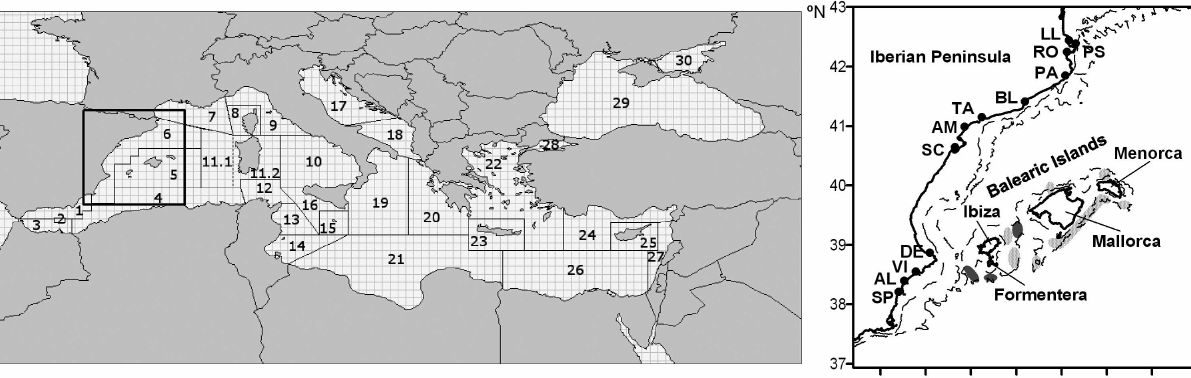
Fig . 1. – Map of the Mediterranean Sea showing the thirty geographical sub-areas (GSAs) established by the General Fisheries Commission for the Mediterranean (GFCM). The inlet details GSA05 (Balearic Islands) and GSA06 (Northern Spain) showing the names of several ports from GSA06 and the different islands of the Balearic Archipelago mentioned in the work; the isobaths are 100 and 800 m. Red shrimp and caridean shrimp fishing grounds of GSA05 exploited by trawlers from GSA06 are also shown in dark grey and grey respectively (adapted from García-Rodríguez and Esteban, 1999; and García-Rodríguez et al. 2000). LL: Llançà; PS: Port de la Selva; RO: Roses; PA: Palamós; BL: Blanes; TA: Tarragona; AM: Ametlla de Mar: SC: Sant Carles de la Ràpita; DE: Denia; VI: Villajoyosa; AL: Alicante; SP: Santa Pola. The number and name of all GFCM-GSAs are: 01 Northern Alboran Sea; 02 Alboran Island; 03 Southern Alboran Sea; 04 Algeria; 05 Balearic Islands; 06 Northern Spain; 07 Gulf of Lions; 08 Corsica Island; 09 Ligurian and North Tyrrhenian Sea; 10 South Tyrrhenian Sea; 11.1 Sardinia (west); 11.2 Sardinia (east); 12 Northern Tunisia; 13 Gulf of Hammamet; 14 Gulf of Gabes; 15 Malta Island; 16 South of Sicily; 17 Northern Adriatic; 18 Southern Adriatic Sea; 19 Western Ionian Sea; 20 Eastern Ionian Sea; 21 Southern Ionian Sea; 22 Aegean Sea; 23 Crete Island; 24 North Levant; 25 Cyprus Island; 26 South Levant; 27 Levant; 28 Marmara Sea; 29 Black Sea; and 30 Azov